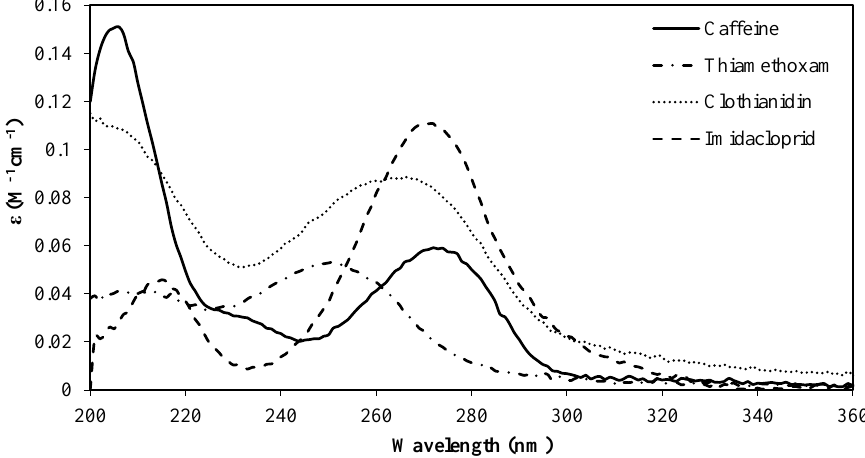
Figure 1. Decadic molar extinction coefficient of the